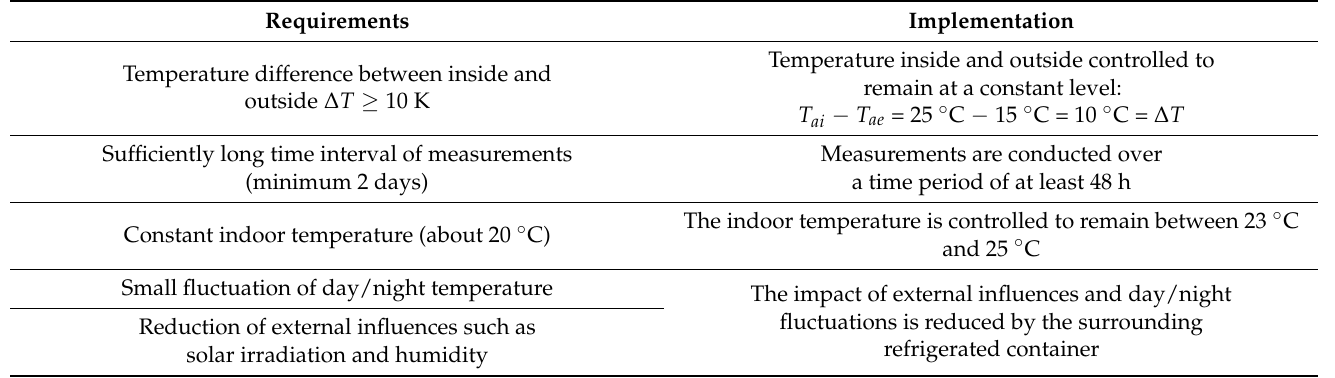
Table 1. Methodical requirements for the heat flux measurements [36] and their implementation in the conducted experiments.